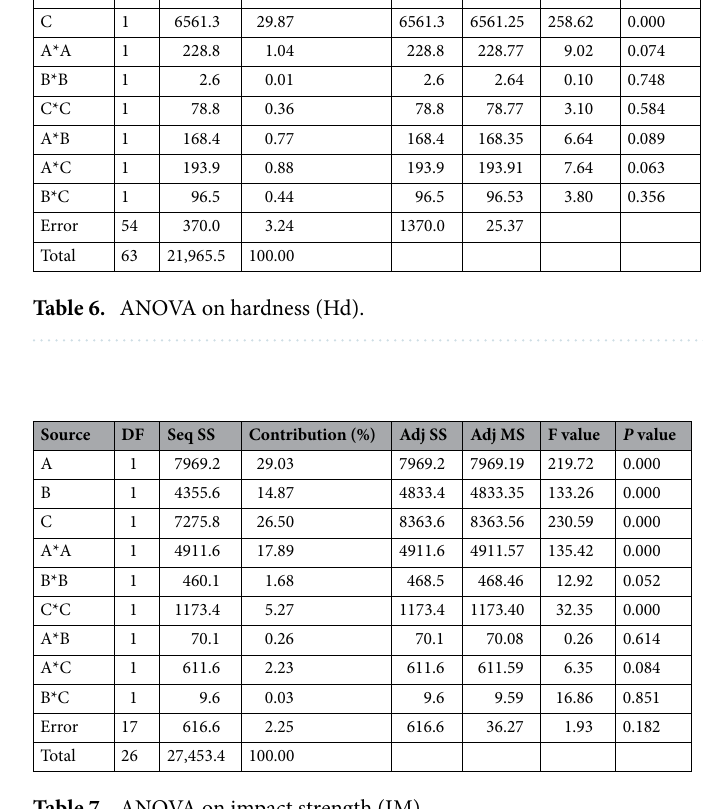
Table 7. ANOVA on impact strength (IM).